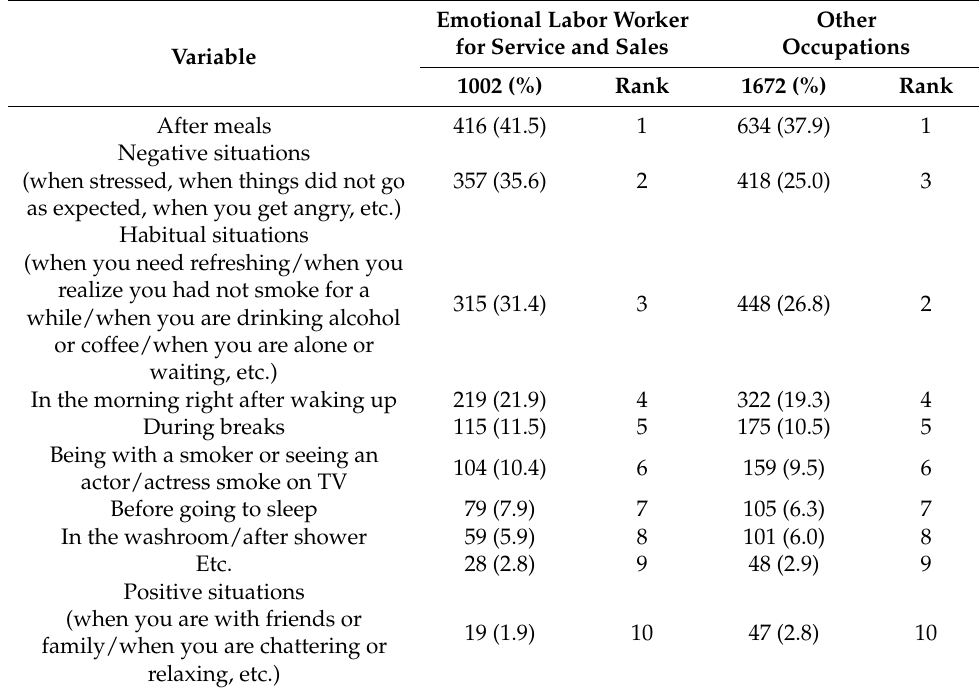
When is the most difficult time to resist the urge to smoke during the day? (multiple